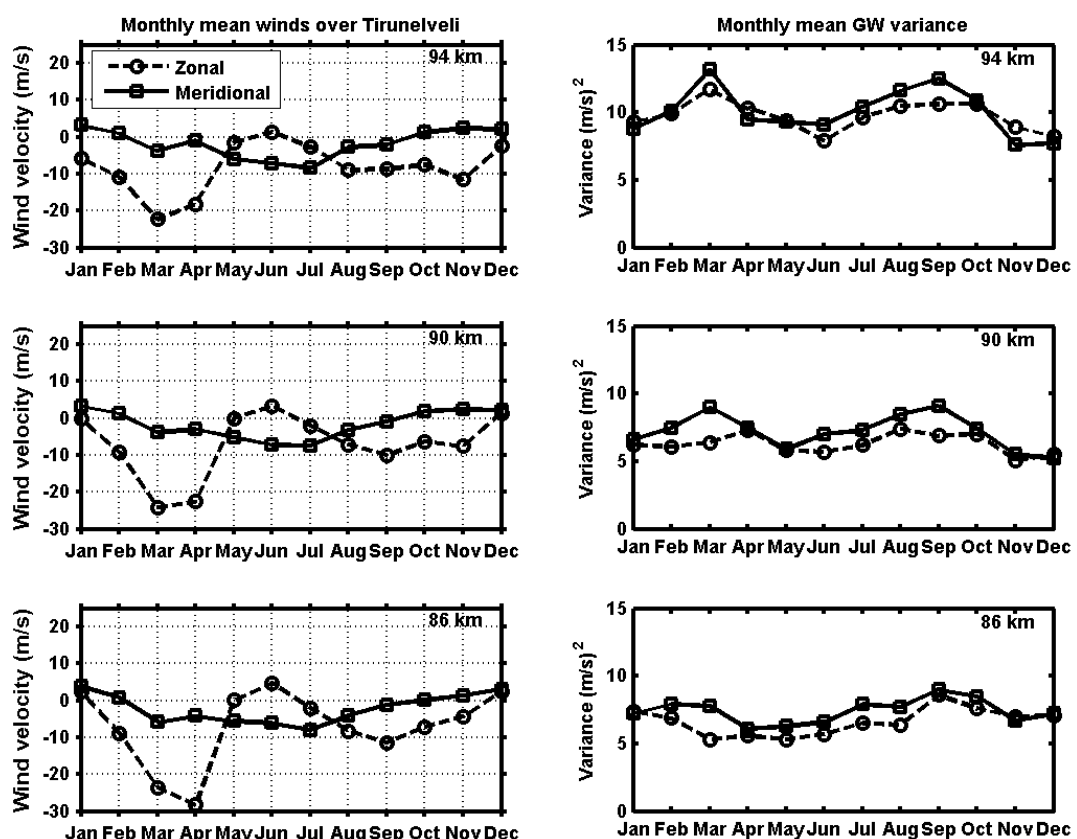
Fig. 1. Monthly mean zonal and meridional winds over Tirunelveli (left panels) and monthly mean gravity wave variances in zonal and meridional winds (right panels) for the altitudes 86, 90 and